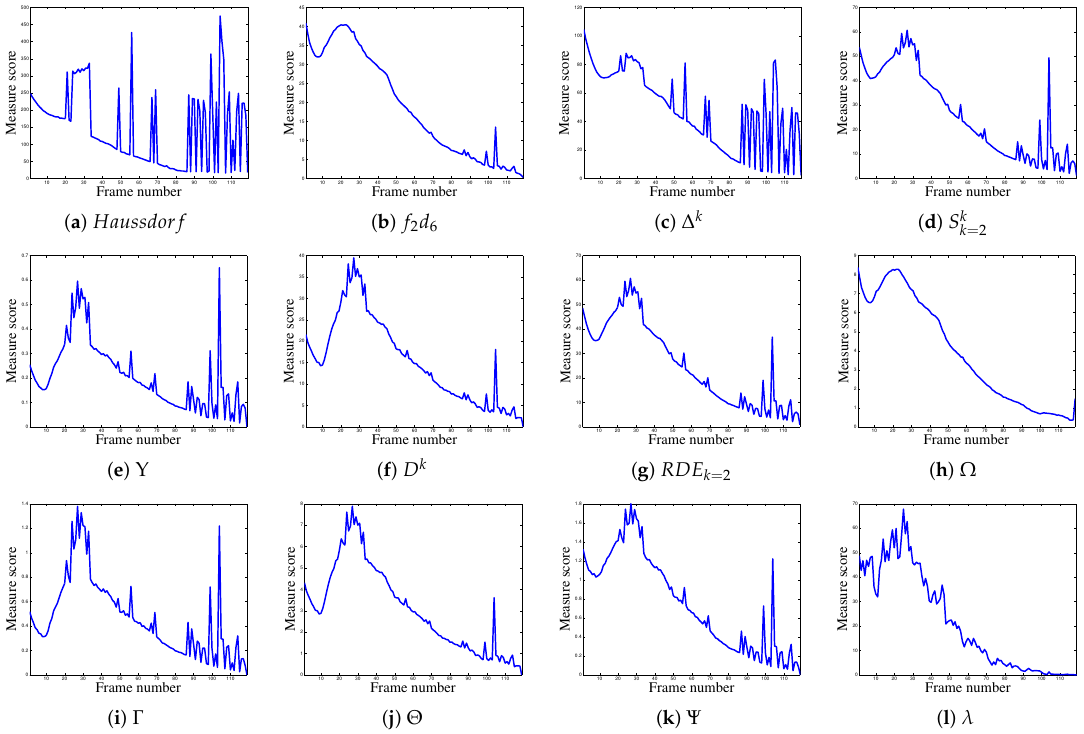
Figure A1. Behaviors of non-normalized localization metrics on real experiment with noisy images tied to video 2 (V2), with images of size 720 × 1280, see Figure 5.